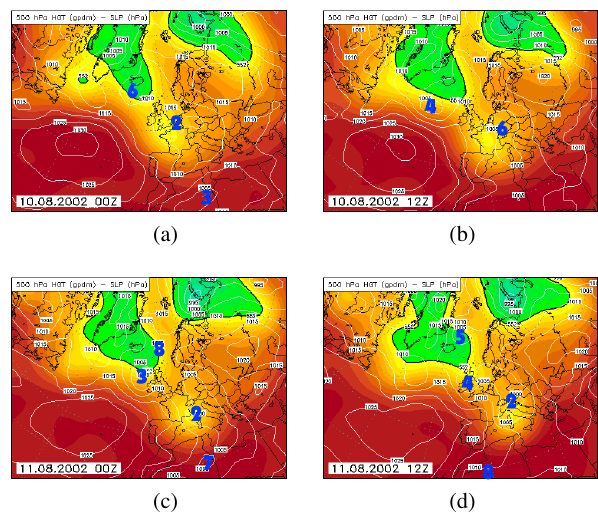
Figure 8. As in Fig. 7, but for 10 and 11 August 2002. Figure 8 : As in Fig. 7, but for 10 and 11 August, 2002.